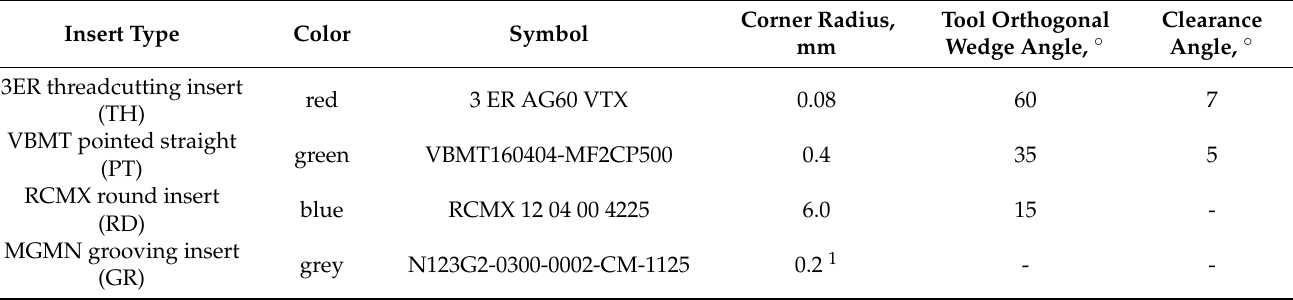
Figure 2. The indexable inserts used in the experimentL ( a ) 3ER threadcutting insert (TH), ( b )VBMT pointed straight insert (PT), ( c ) RCMX round insert (RD), and ( d ) MGMN grooving insert (GR). Table 1. Basic geometrical parameters of used cutting inserts.